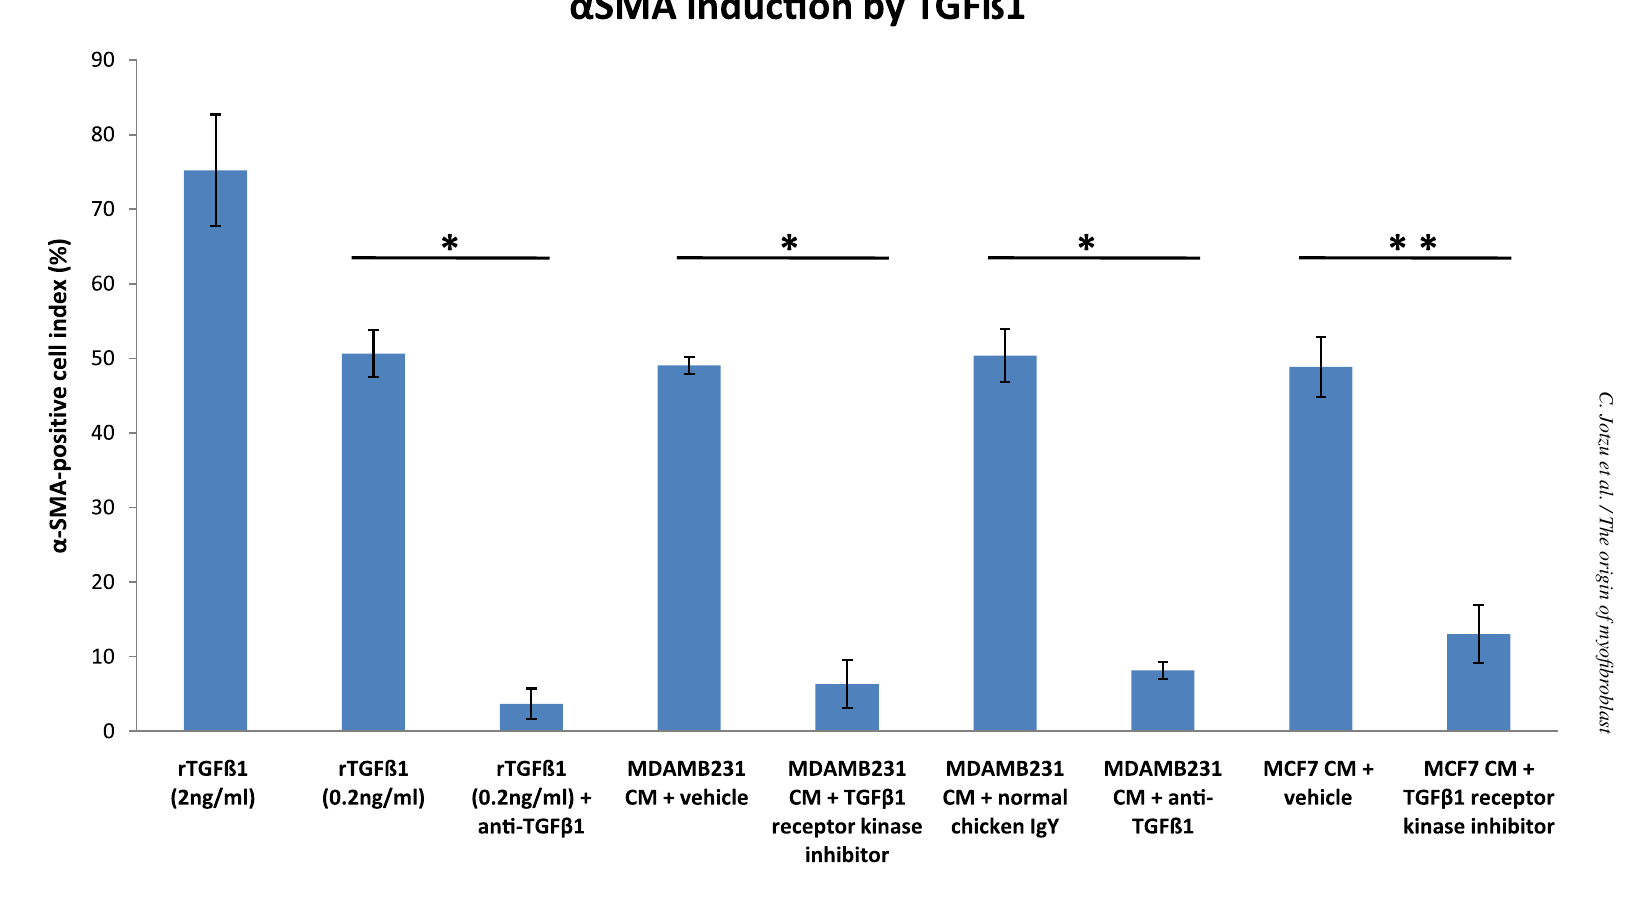
Fig. 4. TGF β 1 is critical to hASC differentiation towards myofibroblast-like cells. Serum-starved hASCs were treated with different concentrations of recombinant TGF β 1 (0.2 and 2 ng/ml) or cultured in MDAMB231 conditioned medium (0% FBS; 24 h conditioning time) for 4 days in the presence of anti-TGF β 1 neutralizing antibody (0.2 µg/ml) or control normal chicken IgY (0.2 µg/ml). For inhibition of TGF β 1 activin receptor-like kinases hASCs were pretreated with vehicles (DMSO) or 10 µM SB431542 for 30 min and then exposed to CM from either MDAMB231 or MCF7 cancer cells for 4 days. The quantitative expression of α -SMA in hASCs was analyzed by immunofluorescence staining and cells positive for α -SMA where counted as a fraction of total cell numbers in each group. Data represent average value ± SD ( n = 3). * P < 0 . 0001, ** P < 0 . 0004. CM – conditioned medium; α -SMA – alpha smooth muscle actin; rTGF β 1 – recombinant transforming growth factor beta 1. (The colors are visible in the online version of the